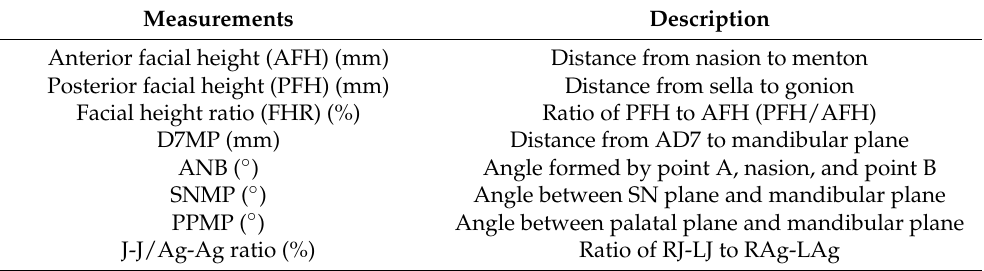
Table 1. Linear and angular measurements on lateral and frontal cephalograms.